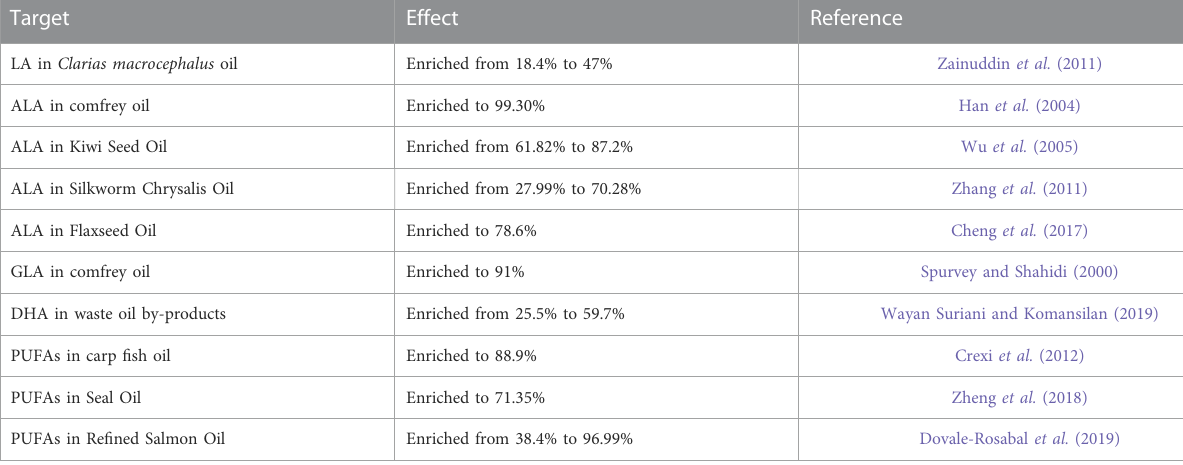
TABLE 7 The effects of urea inclusion for PUFAs